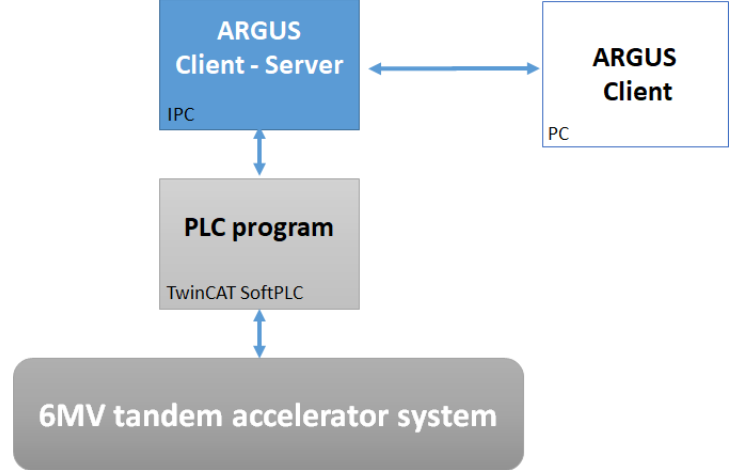
Figure 2. Tandetron control system architecture.